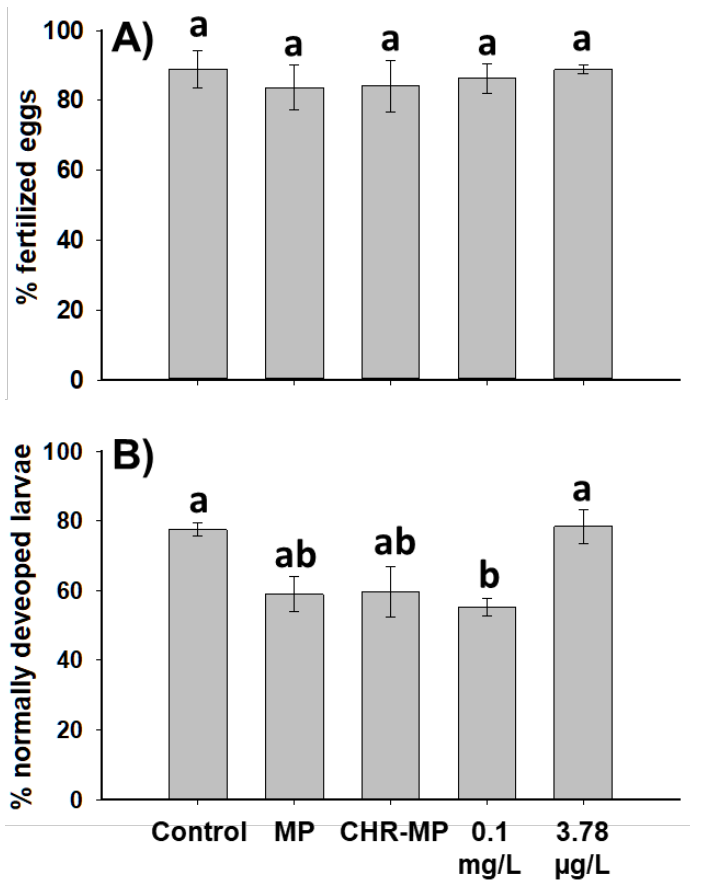
Figure 1. Mean percentage ( ± SEM, n = 5) of fertilized mussel eggs ( A ) and normally developed D-veliger larvae ( B ) measured after exposure to 25 × 10 3 units/mL FSW of polystyrene microplastics (MP) and chrysene-loaded microplastics (CHR-MP), 0.1 mg/L and 3.78 µg/L of freely dissolved CHR (without MP). Different letters denote statistically significant differences ( p < 0.05, ANOVA— Bonferroni post-hoc comparison) among treatments.